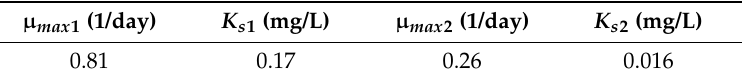
Table 4. A particular set of optimized parameters taken randomly from the final optimized parameter sets.